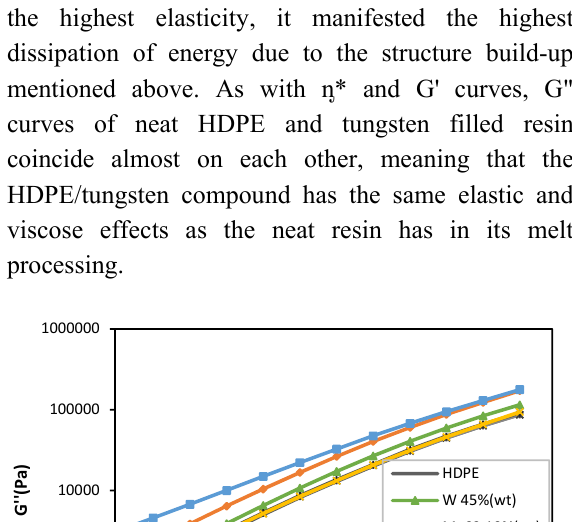
Fig. 13. Tensile bar chart of HDPE and its prepared